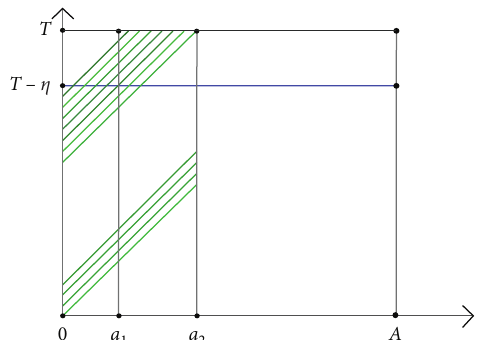
+ T < η < T , all the 1 0